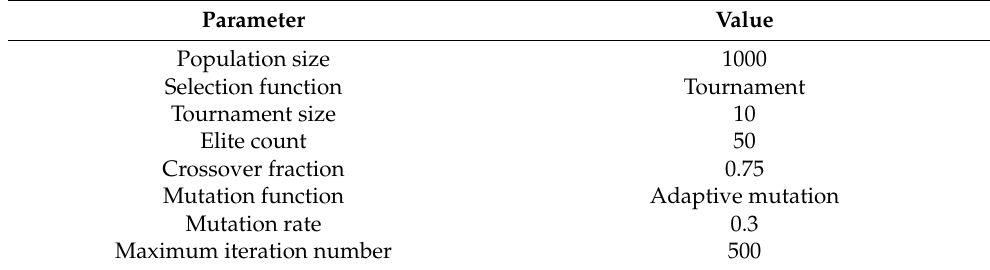
Table 8. Parameter settings of genetic algorithm.